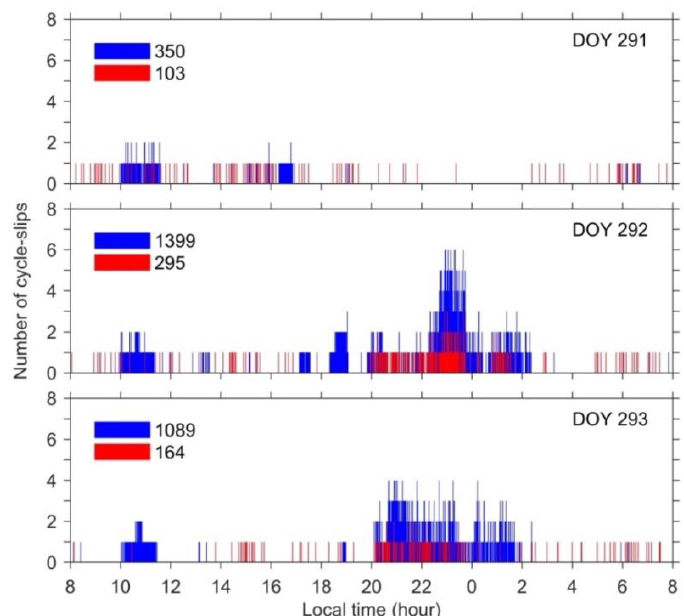
Figure 11. Number of cycle-slips for HKST station on 18, 19, and 20 October 2015. The blue bar shows the result of standard approach, and the red one shows the corresponding result of mitigated approach. The total number of cycle-slips is given in the upper left corner.